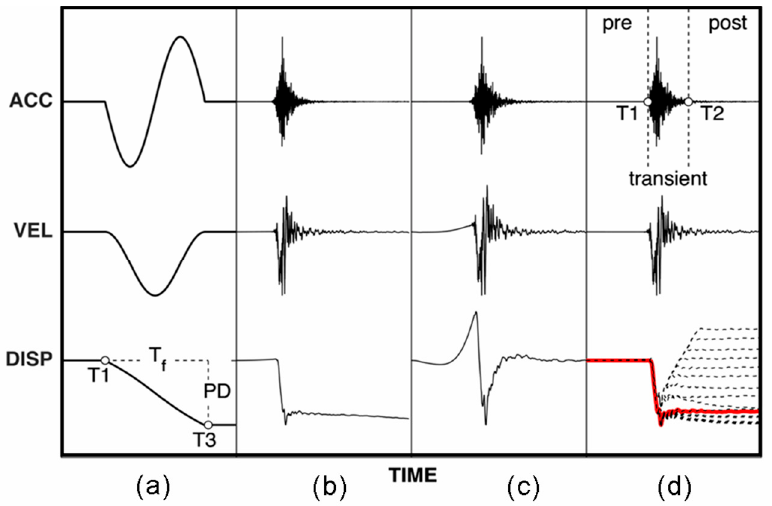
Figure 1. Example of earthquake waveforms processed by means of extended BASeline COrrection (eBASCO) (vertical component recorded at station T1214 during the Mw6.5 Norcia earthquake) from [9]. ( a ) analytical model of the fling-step in terms of acceleration, velocity, and displacement; ( b ) uncorrected waveforms; ( c ) waveforms corrected through a standard processing characterized by broad-band filtering and the application of a cosine taper both at the beginning and the end of the signal; ( d ) waveforms corrected by the eBASCO tri-linear detrend. Pre-, transient- and post-event windows are highlighted by the T 1 and T 2 correction points. T 3 represents the time at which the ground displacement just reached the final offset. T f and permanent displacement amplitude (PD) are the period of the sine pulse and the amplitude of the permanent displacement, respectively. Red line: eBASCO ground displacement corresponding to the maximum flatness indicator (f-value); dashed black lines: displacement waveforms corresponding to different T 1 and T 2 correction points.